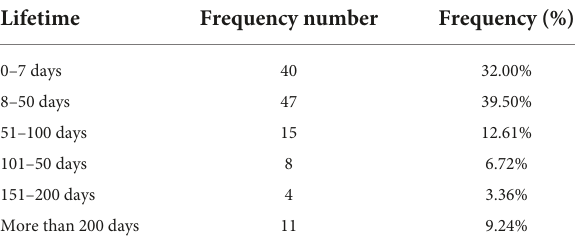
TABLE 3 Duration